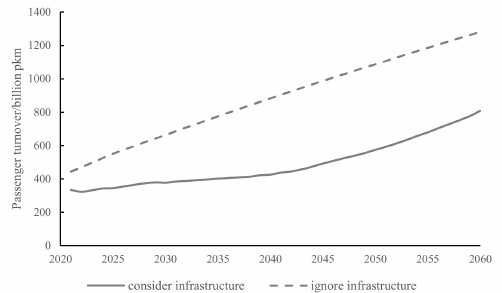
Figure 12. The passenger turnover offered by subways in two